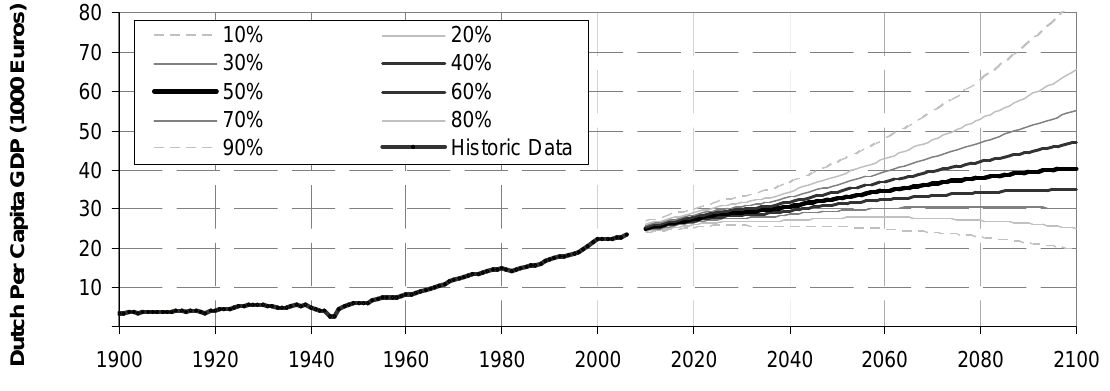
Figure 12. Probabilistic Forecast for the development of the Dutch GDP